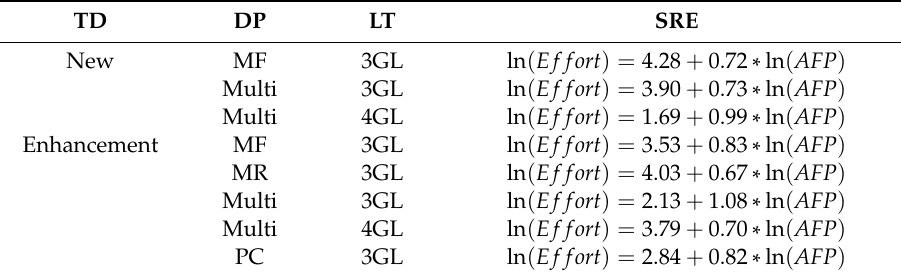
Table 7. SREs for predicting the e ff ort of new and enhancement